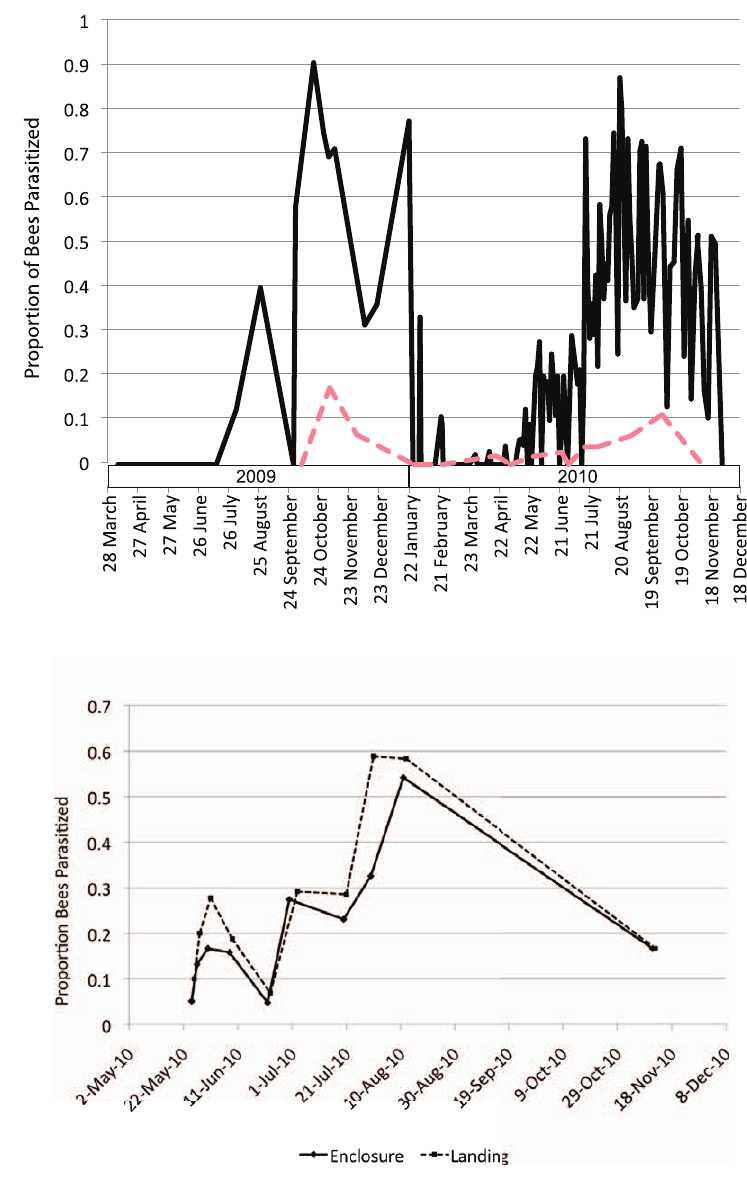
Figure 3. Rates of phorid parasitism in honey bees. (A) Rates of parasitism for bees sampled from April 2009 through November 2010. Black solid line shows rates in stranded bees from under lights on the San Francisco State University campus, while the pink dashed line shows rates in foraging bees. Stranded bees found under lights were sampled at irregular intervals during 2009 and sampled every two days in 2010. Foragers were sampled monthly from our main study hive. A rate of zero indicates that samples from that period contained no parasitized bees. We compared rates of parasitism in stranded and active foraging bees collected at San Francisco State University from October 2009 through January 2010 and from July 2010 to December 2010 (when parasitism rates peaked). 2009–2010 peak rates of parasitism in samples of stranded bees (Mean=60%, n=276) were significantly higher than peak rates of parasitism in active foragers from our main study hive (Mean=6%, n=164) ( x 2 =126.7, d.f. 1, p , 0.0001). This pattern repeated in 2010 when peak rates of parasitism in samples of stranded bees (Mean=50%, n=860) were again significantly higher than rates of parasitism in active foragers (Mean=4%, n=422) ( x 2 =255.3, d.f. 1, p , 0.0001). (B) Proportion of honey bees parasitized by phorids in samples from stranded bees collected from the Hensill Hall landing under lights (dotted line) and from samples of bees collected from overnight hive enclosures on adjacent nights (solid line). Parasitism rates of bees trapped in the enclosures closely track rates in stranded bees found under lights during the same period and the number of bees found under lights significantly declined when the enclosure was in place (Welch’s t-test p , 0.0001) indicating that stranded bees came from our main study hive and were parasitized prior to abandoning the hive. doi:10.1371/journal.pone.0029639.g003 higher rate of parasitism than foragers ( x 2 = 255.3, d.f. 1, (Mean = 4%, Range = 0%–11%, n = 422 bees). These peaks in infection occurred just prior to or during the time of year when p , 0.0001). Parasitism rates in stranded bees again peaked at nearly 90% (Mean = 50%, SD = 19, Range = 11%–88%, n = 860 losses of honey bee colonies from CCD and other causes peak in bees) while foragers had a much lower rate of parasitism